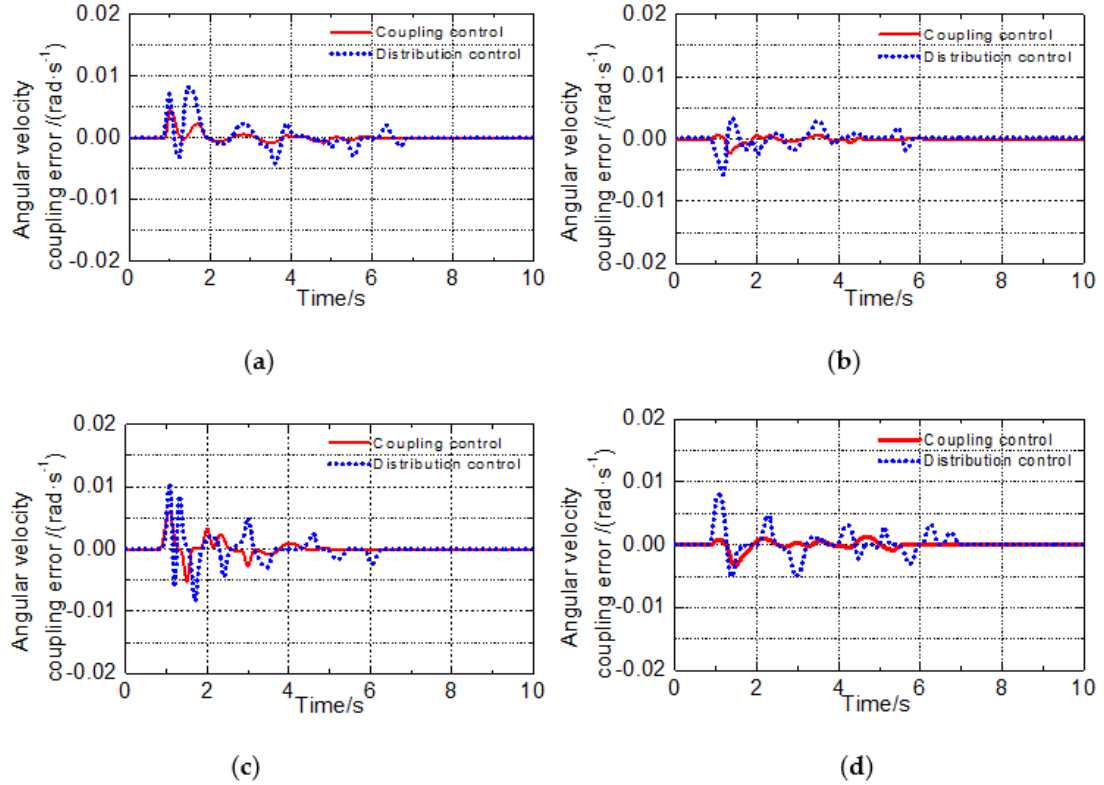
Figure 11. Angular velocity coupling errors of motion mode switching: ( a ) cross motion; ( b ) in-place rotation; ( c ) diagonal motion; ( d ) steering